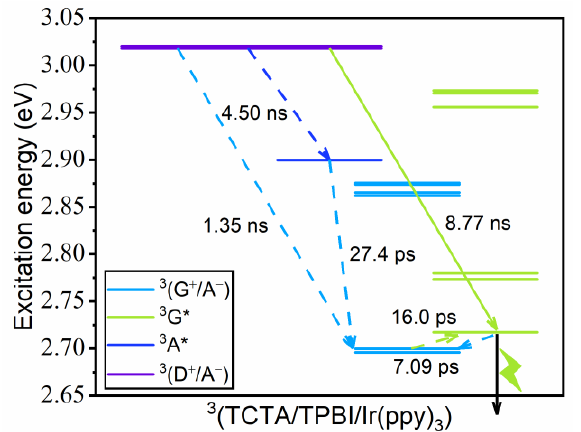
Figure 10. The time scales of important transitions in 3 (TCTA/TPBI/Ir(ppy) 3 ). Solid and dashed lines indicate EET and CT processes, respectively.